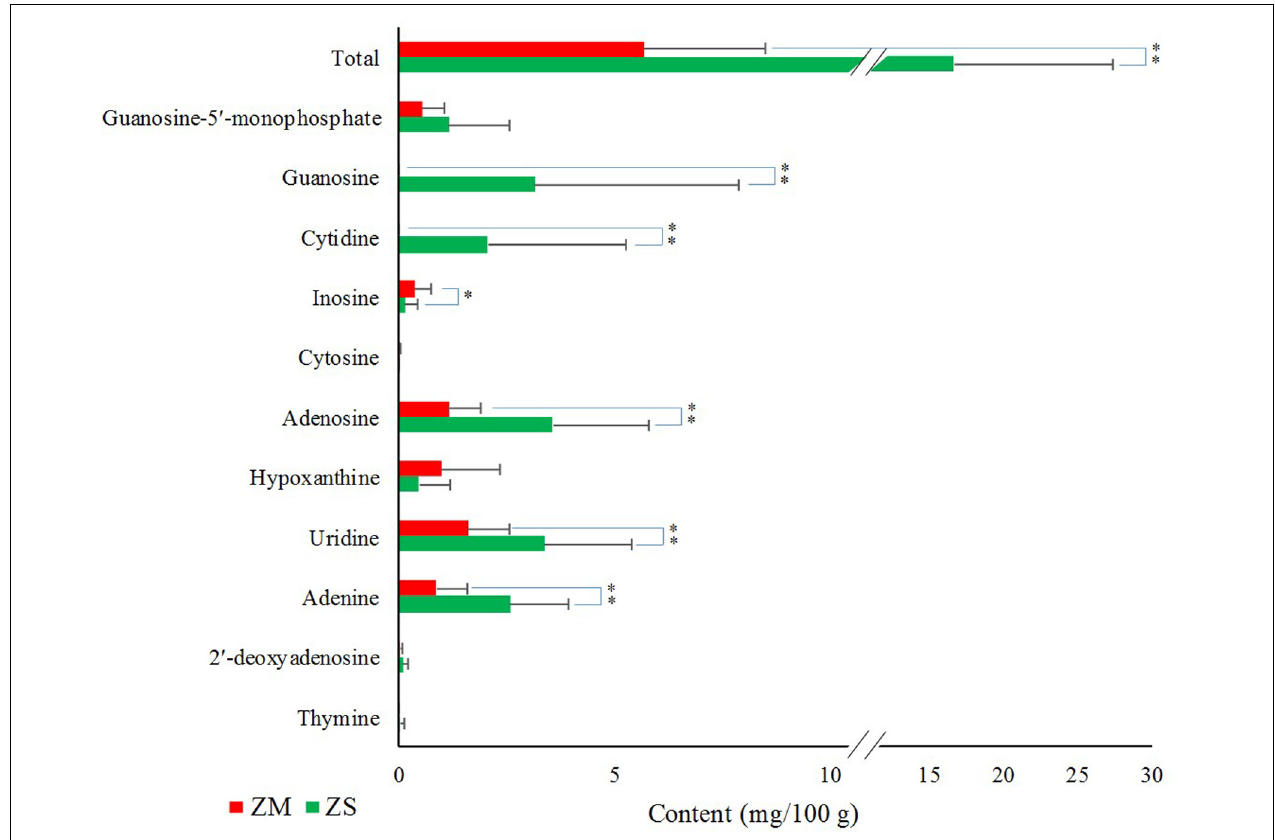
FIGURE 4 | Contents of nucleosides and nucleobases (mg/100 g) in the seeds of Z. jujuba var. spinosa (ZS) and Z. mauritiana (ZM). ∗ P < 0.05, ∗∗ P <